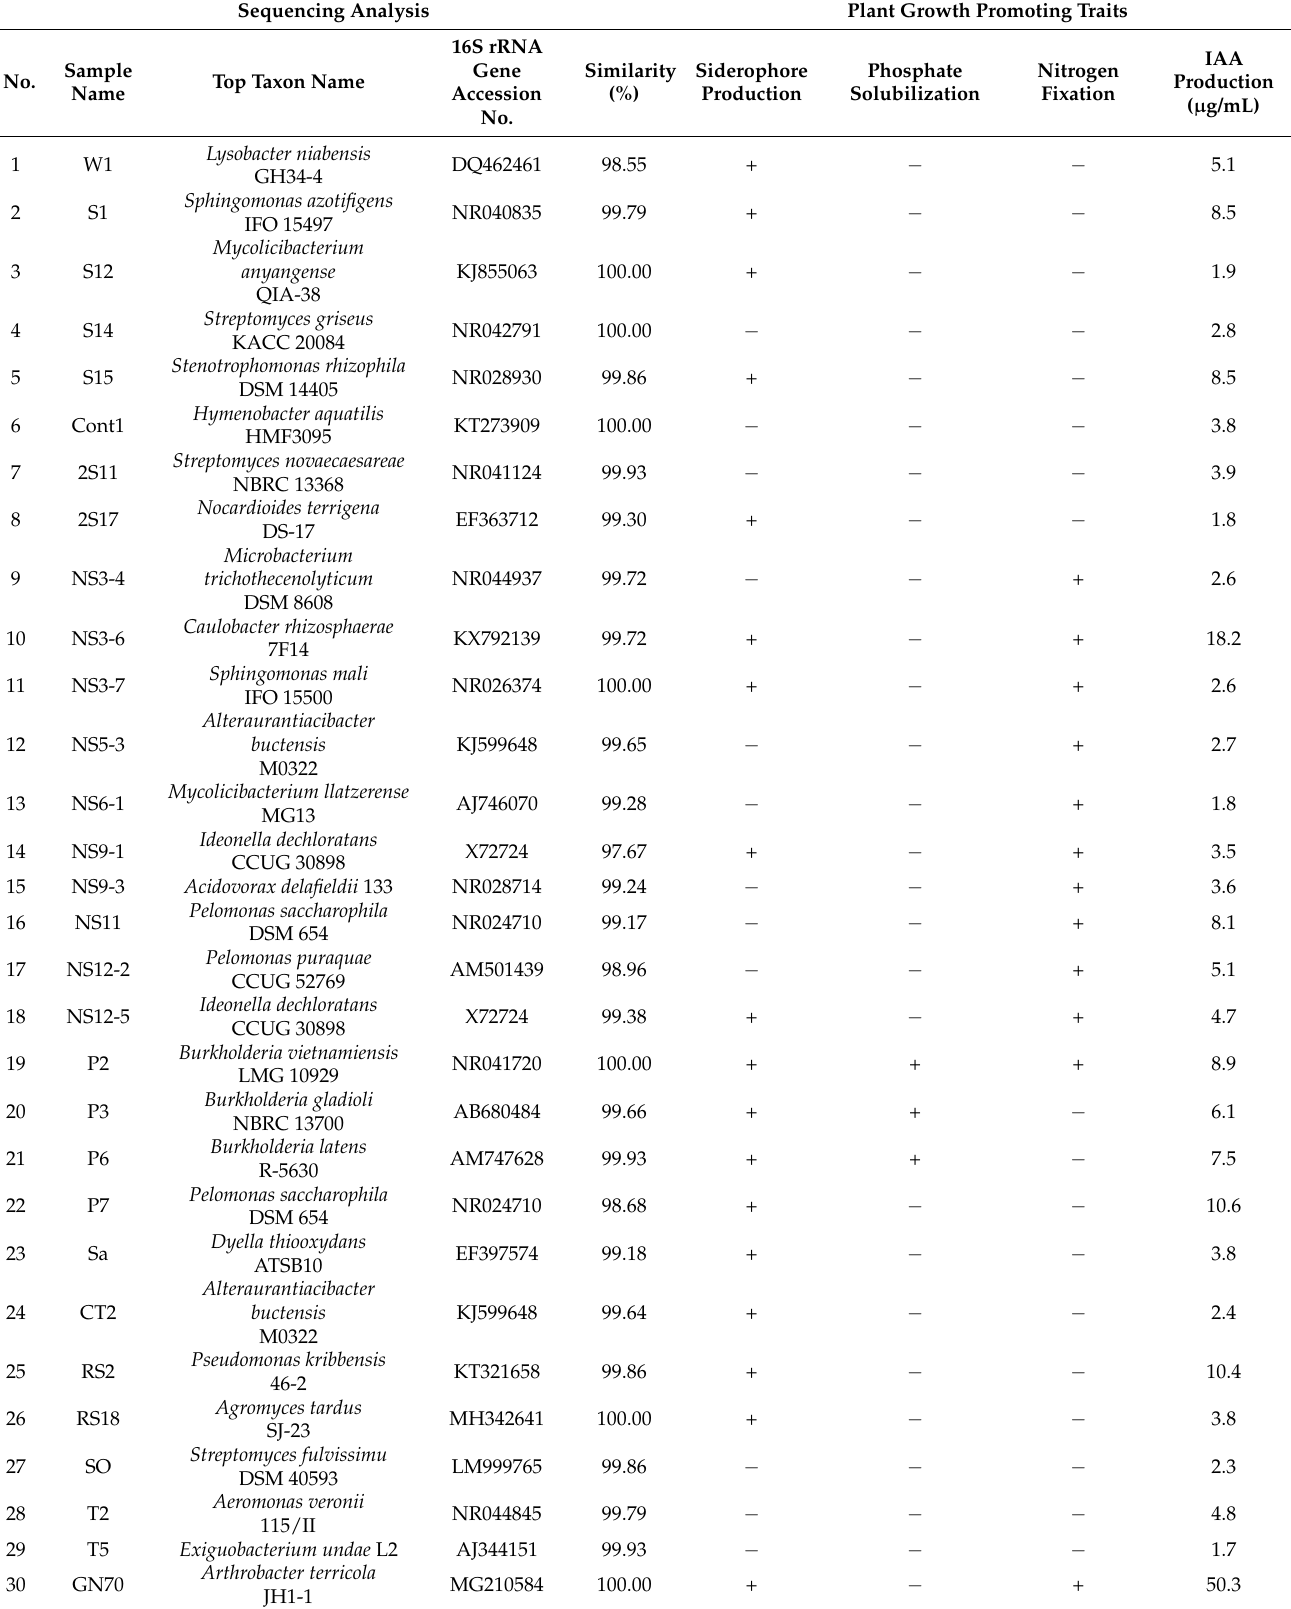
Table 1. Sequence analysis of the 16S rRNA gene and plant growth-promoting properties of the 30 bacterial endophytes isolated from the rhizosphere of Oryza sativa . L. +, Positive; − ,